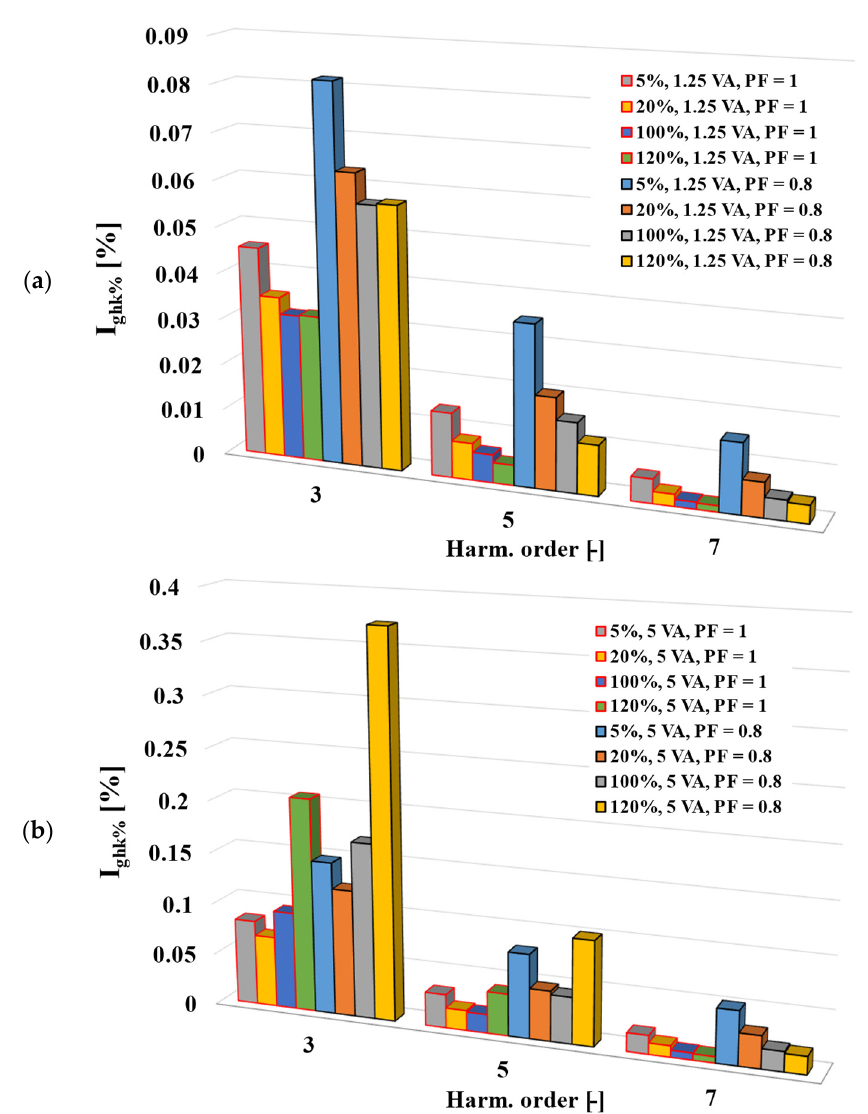
Figure 8. Comparison of the percentage values of the self-generated low-order higher harmonics determined for inductive CT 300 A/5 A with two power factors and ( a ) 25% of the rated load and ( b ) the rated load [12].